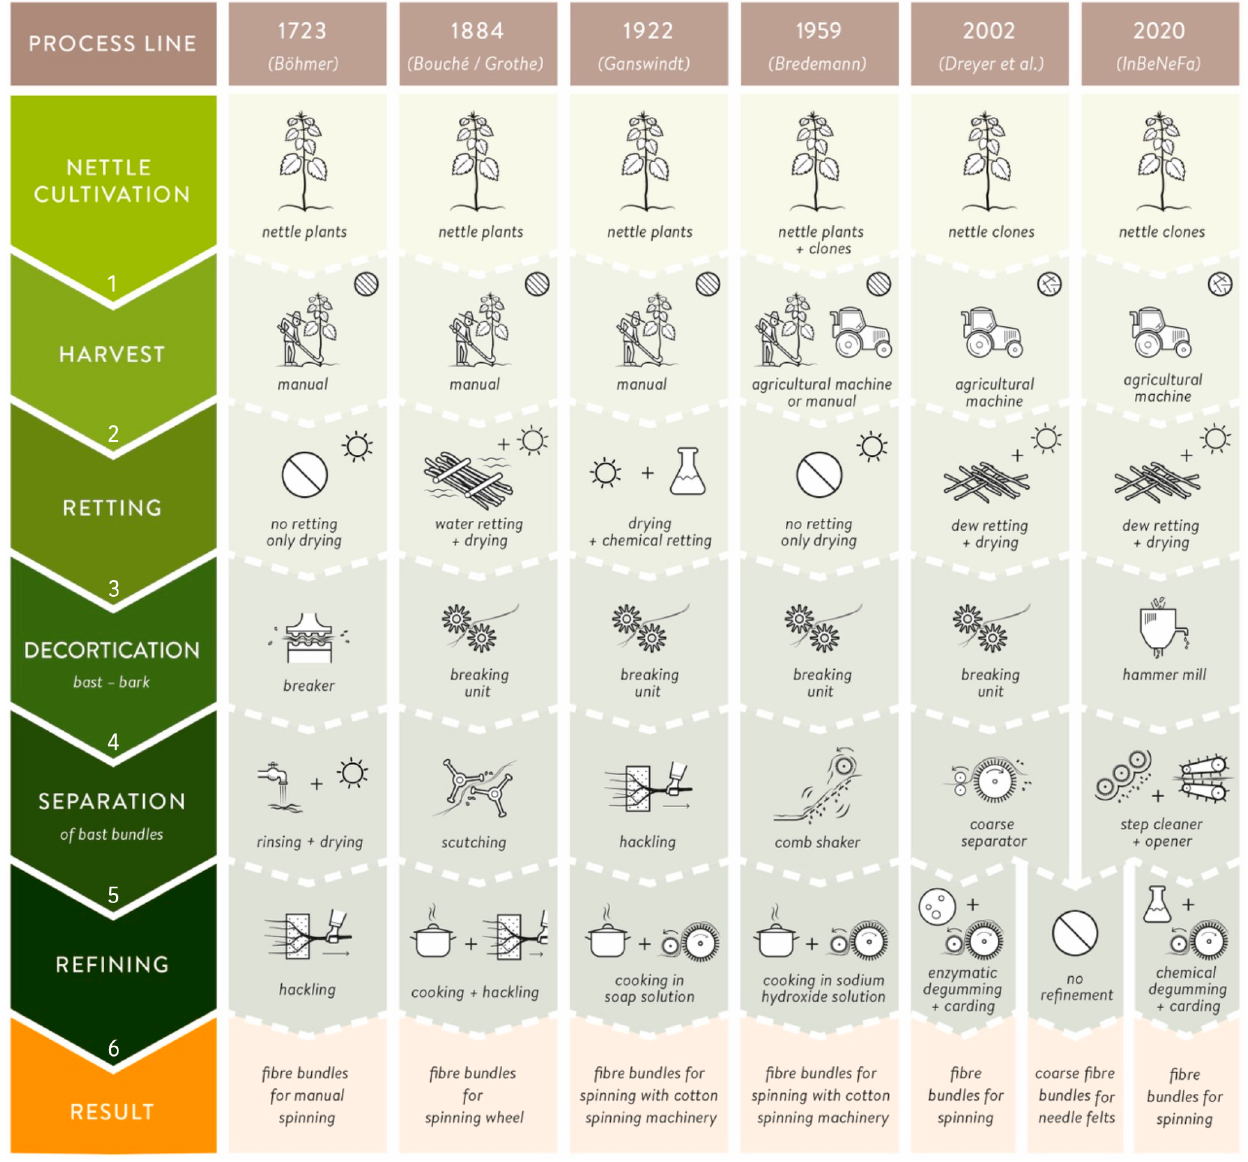
Figure 2. Longitudinal ( ) and disordered ( ) process lines for nettle fiber extraction and separa- tion from 1723 until present.